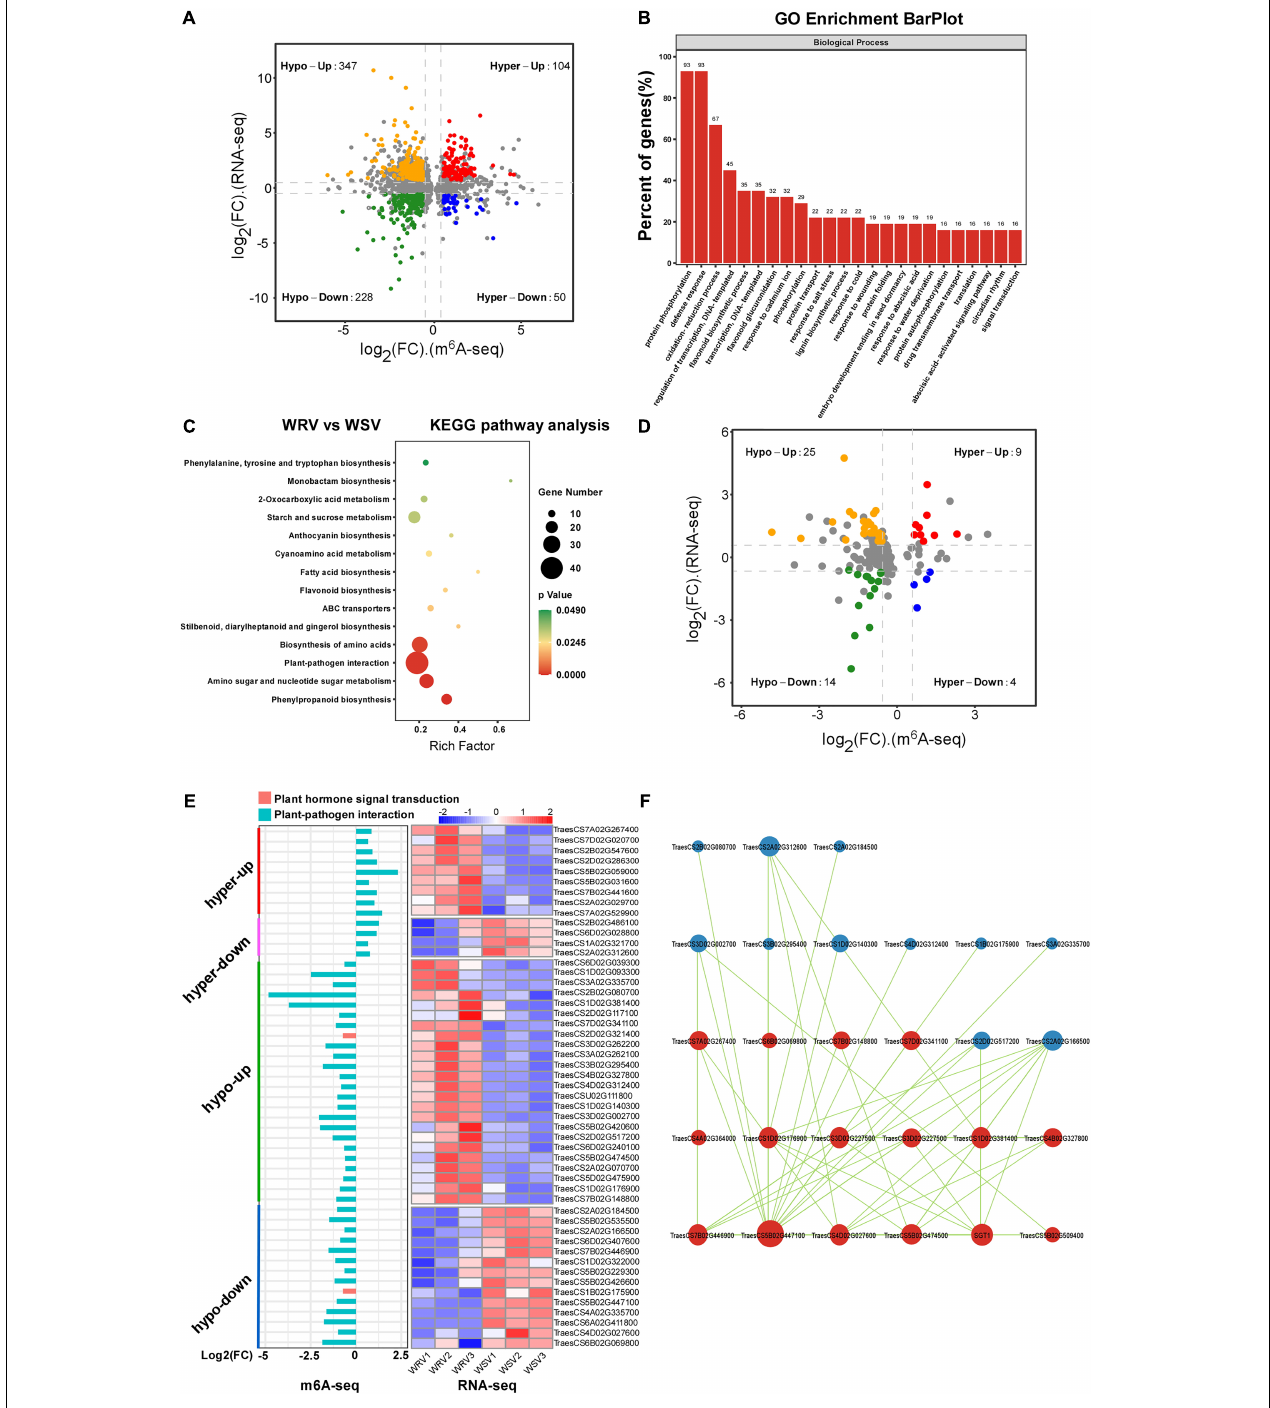
FIGURE 4 | Conjoint analysis of m 6 A-seq and RNA-seq data. (A) A four-image map to analyze the relationship between differential genes and differential peaks and to screen out genes with a significant change in both m 6 A and mRNA levels in WRV samples compared with WSV samples (fold change > 1.5, p < 0.05). (B) Gene Ontology analysis of biological processes of genes with a significant change in both m 6 A and mRNA levels. The vertical axis represents the proportion of selected genes enriched in each pathway. (C) KEGG pathway enrichment analysis of the genes with a significant change in both m 6 A and mRNA levels. The horizontal axis represents the rich factor of each pathway. (D) Distribution of genes with a significant change in both m 6 A and mRNA levels that were enriched in the plant–pathogen interaction pathway and plant hormone signal transduction pathway (fold change > 1.5, p < 0.05). (E) Heat map and bar diagram of “hyper-up,” “hyper-down,” “hypo-up,” and “hypo-down” genes represented in D . Left, m 6 A-seq; right, RNA-seq. The red column represents genes enriched in both pathways,